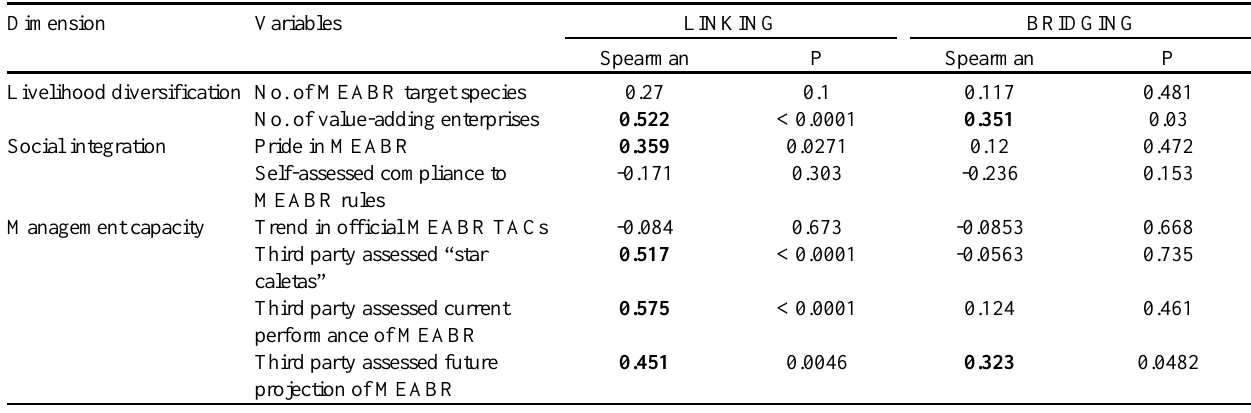
Table 3 . Spearman correlations between linking and bridging social capital indices and comanagement performance variables. MEABR = Management and Exploitation Areas for Benthic Resources.